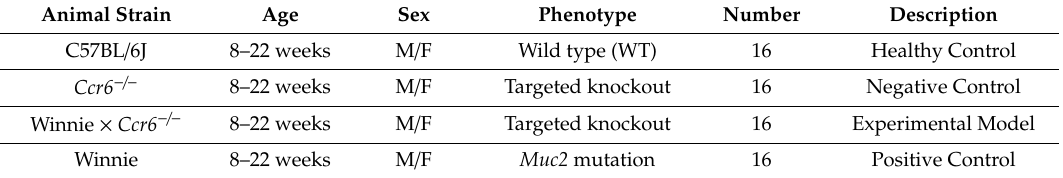
Table 1. Experimental strains of mice utilised with a description of age, sex, phenotype, sample size and their role in the research project. The mice were utilised in two batches, at 8 weeks and 16–22 weeks for separate pre-clinical